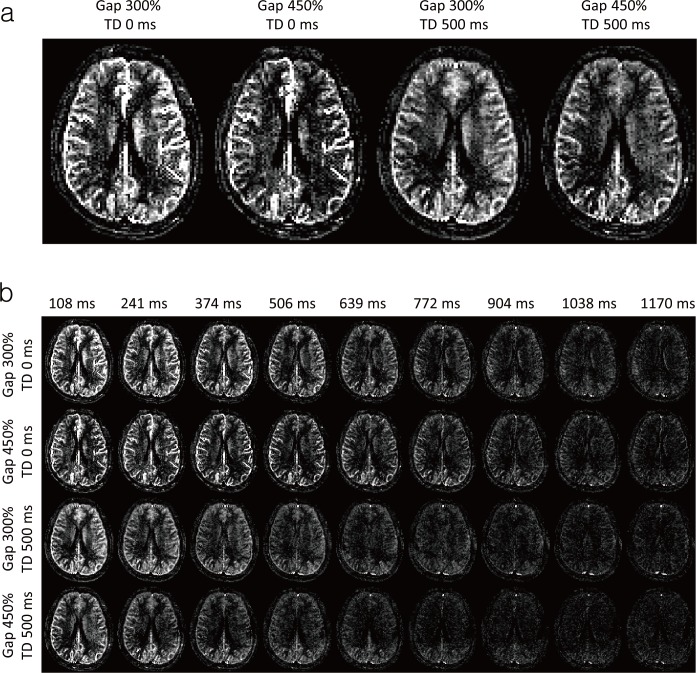
A representative dataset of multiphase ALADDIN with different gap sizes (300% and 450% of slice thickness) and different inter-slice delay time (TD) (0 and 500 ms) from one representative subject.(a) The enlarged perfusion-weighted images at the first phase. (b) The perfusion-weighted images from the multiple phases. The time phase of perfusion-weighted images is marked on top of each column. Scan time for 0-ms TD and 500-ms TD was 4.9 min and 6.5 min, respectively.